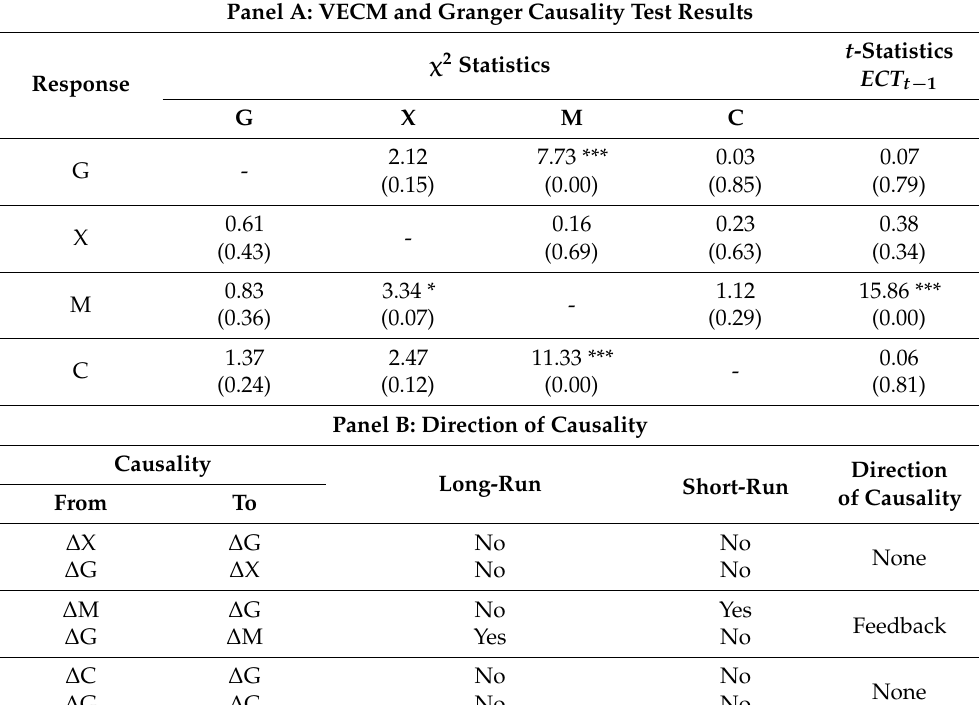
Table 3. VECM and Granger Causality Test Results. Panel A: VECM and Granger Causality Test Results